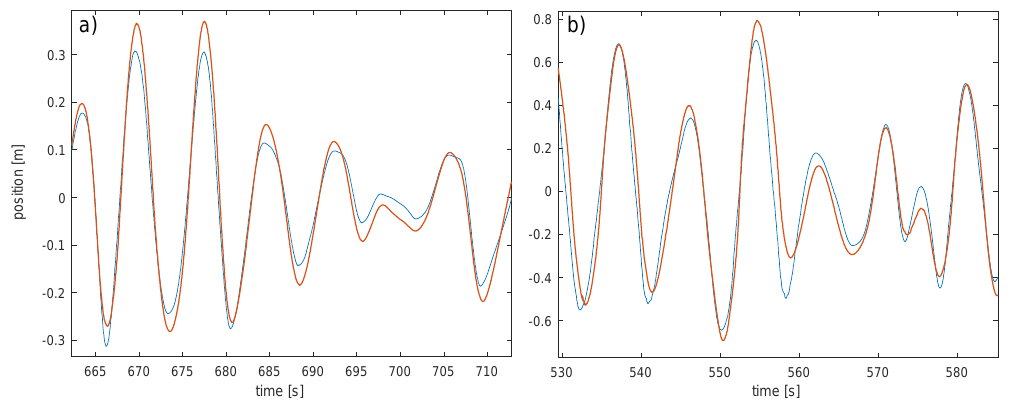
Figure 10. Matrix of generated power ( d PTO v 2 ) for two direct-driven PTOs with different inertia, but same weight, results of the wave tank test.